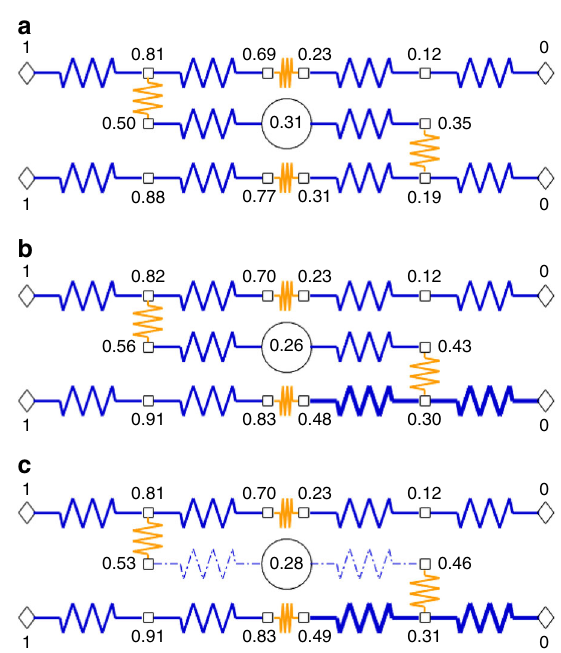
Fig. 8 Ohm ’ s law analogue diagrams of heterogeneously connected xylem. Lumen resistances in blue, end- and side-wall resistances in orange. Pressures set at end nodes (diamonds) to 1 normalized unit upstream and 0 downstream and calculated at other nodes (squares) from network of resistances; fl ow rate through central vessel in normalized units also shown (circle). a Each lumen resistance shown has a value of 0.25 normalized units and wall resistances set to 1. Pattern of connections results in pressure differences among vessels in any given transverse (vertical) slice. b Lumen resistance in bottom-right vessel doubled, pressure drop and fl ow rate across central vessel decrease. c Lumen resistance in central vessel halved, pressure drop decreases further so that fl ow rate only partially recovers; note that, due to network position, fl ow rates in the central vessel (0.28 units), the top-right vessel (0.46, fl ow rate not shown) and the downstream lumen element of the bottom-right vessel (0.62, fl ow rate not shown) are ordered inversely to their resistivities (assuming all lumen elements of equal length), i.e. modelled